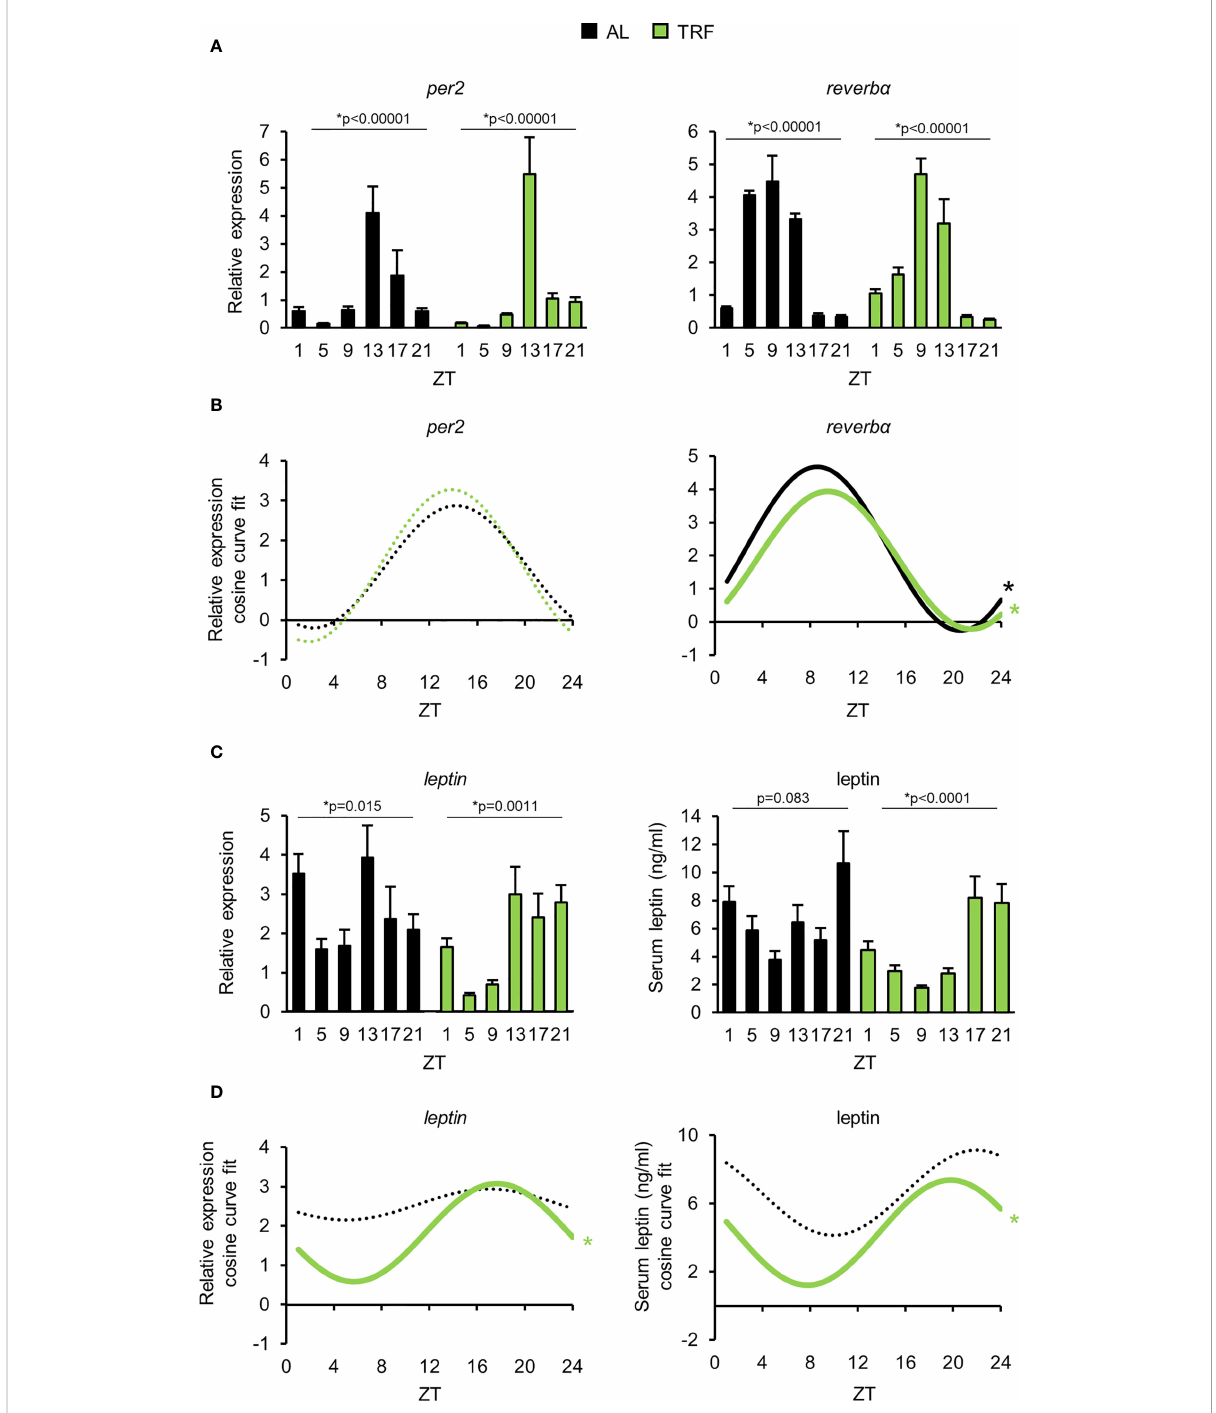
FIGURE 3 Time restricted feeding entrains the peripheral clock of visceral adipose tissue. (A) Relative mRNA expression of per2 and reverb a in the course of the day in visceral adipose tissue (mean + SEM, n = 3-9 (AL), n = 6-11 (TRF), one-way ANOVA, * indicates signi fi cant time effect. (B) Cosine curve fi t to relative expression data showed in (A) . (C) Relative mRNA expression of leptin (mean + SEM, n = 3-9 (AL), n = 6-11 (TRF)) and serum leptin levels in the course of the day (mean + SEM, n = 3-7 (AL), n = 3-8 (TRF)), one-way ANOVA, * indicates signi fi cant time effect. (D) Cosine curve fi t to data showed in (C) . In mRNA expression measurements Rplp0 was used as reference gene. In (B, D) * and solid lines indicate signi fi cant, fi xed 24-hour period cosine curve fi t with cosinor analysis, whereas dashed lines show non-signi fi cant fi t. Parameters of the fi tted cosine curves are listed in Supplementary Table 4. ZT, Zeitgeber